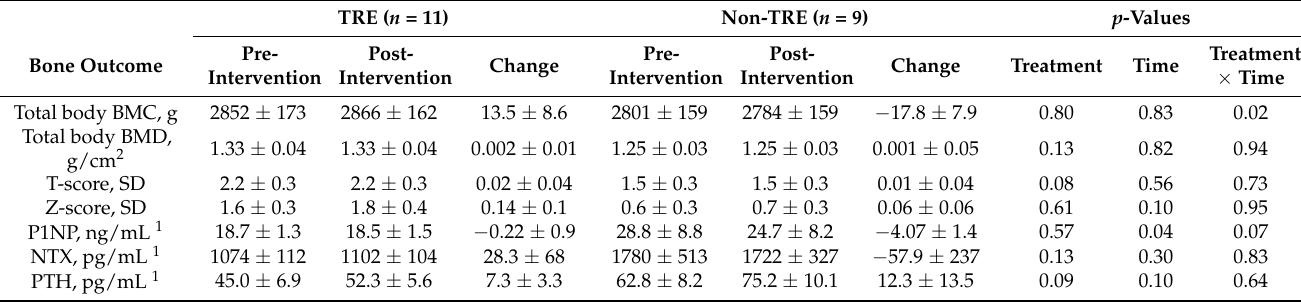
Table 3. Summary of changes in bone